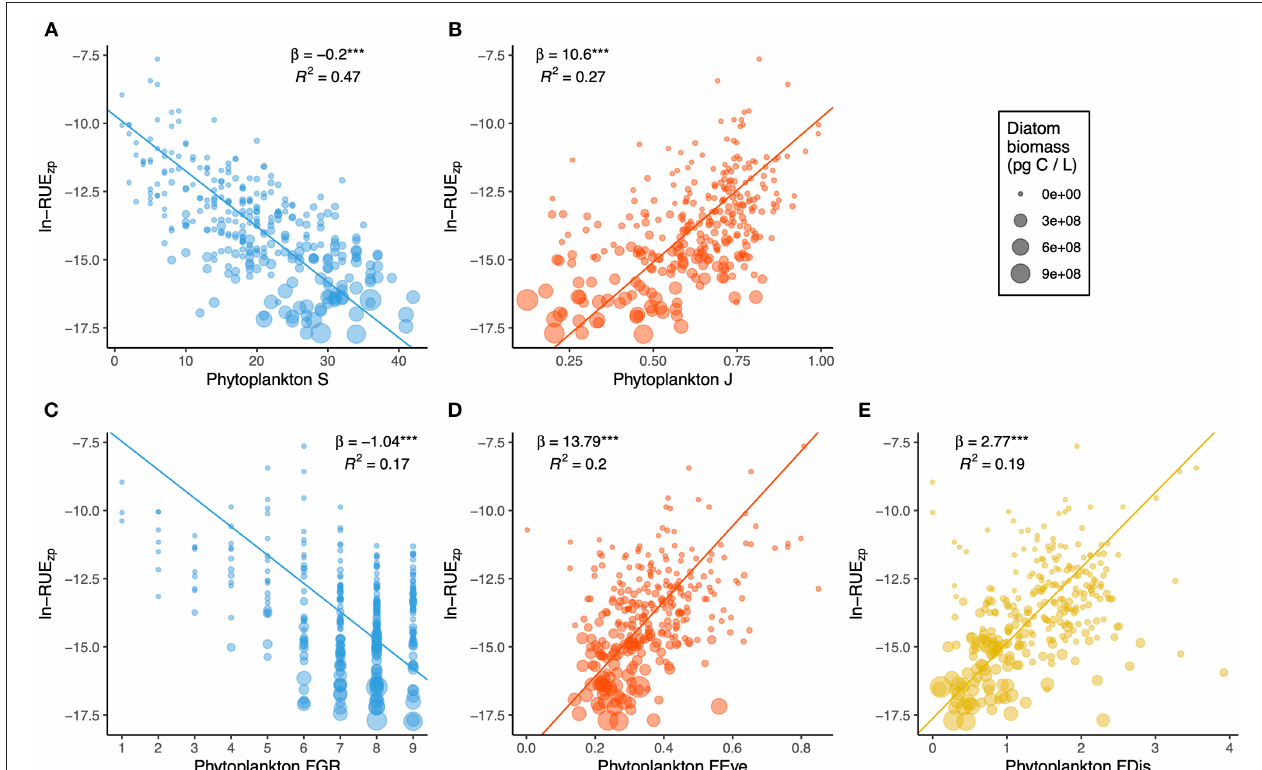
FIGURE 5 | Bivariate plots showing the effects of phytoplankton taxonomic (A,B) and functional (C–E) diversity on RUE zp . Dot size is scaled to diatom biomass, and lines show RMA fits. For each relationship, the slope (and statistical significance with parametric p -value < 0.0001***) and the explanatory power are